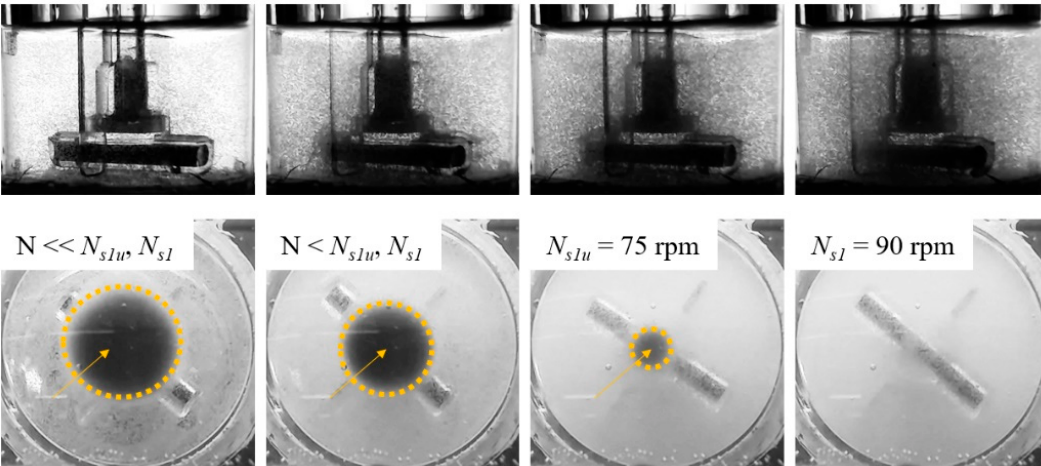
Figure 5. BR44 MC suspension dynamics. Photographic pictures (side and bottom view) of the MC distribution during the suspension studies. N s1 was defined as the impeller speed required just entirely to suspend all MCs. N s1u was defined as the lower limit of N s1 , meaning that some MCs were still located at the bottom of the flask, but none were at rest. Table 2. Overview of N s1u /N s1 and dependent biochemical engineering parameters. (*) P/V values and (**) local volume-weighted mean shear stress levels were derived from Jossen et al. [39]. u tip indicates the maximum expected fluid velocities in a stirred bioreactor. Re is used to classify the fluid flow regime in a stirred bioreactor. P/V represents an important parameter in terms of process scale-up and the estimation of hydrodynamic stresses. τ nt gives an overview of the hydrodynamic stress acting on the cells in a stirred bioreactor system.